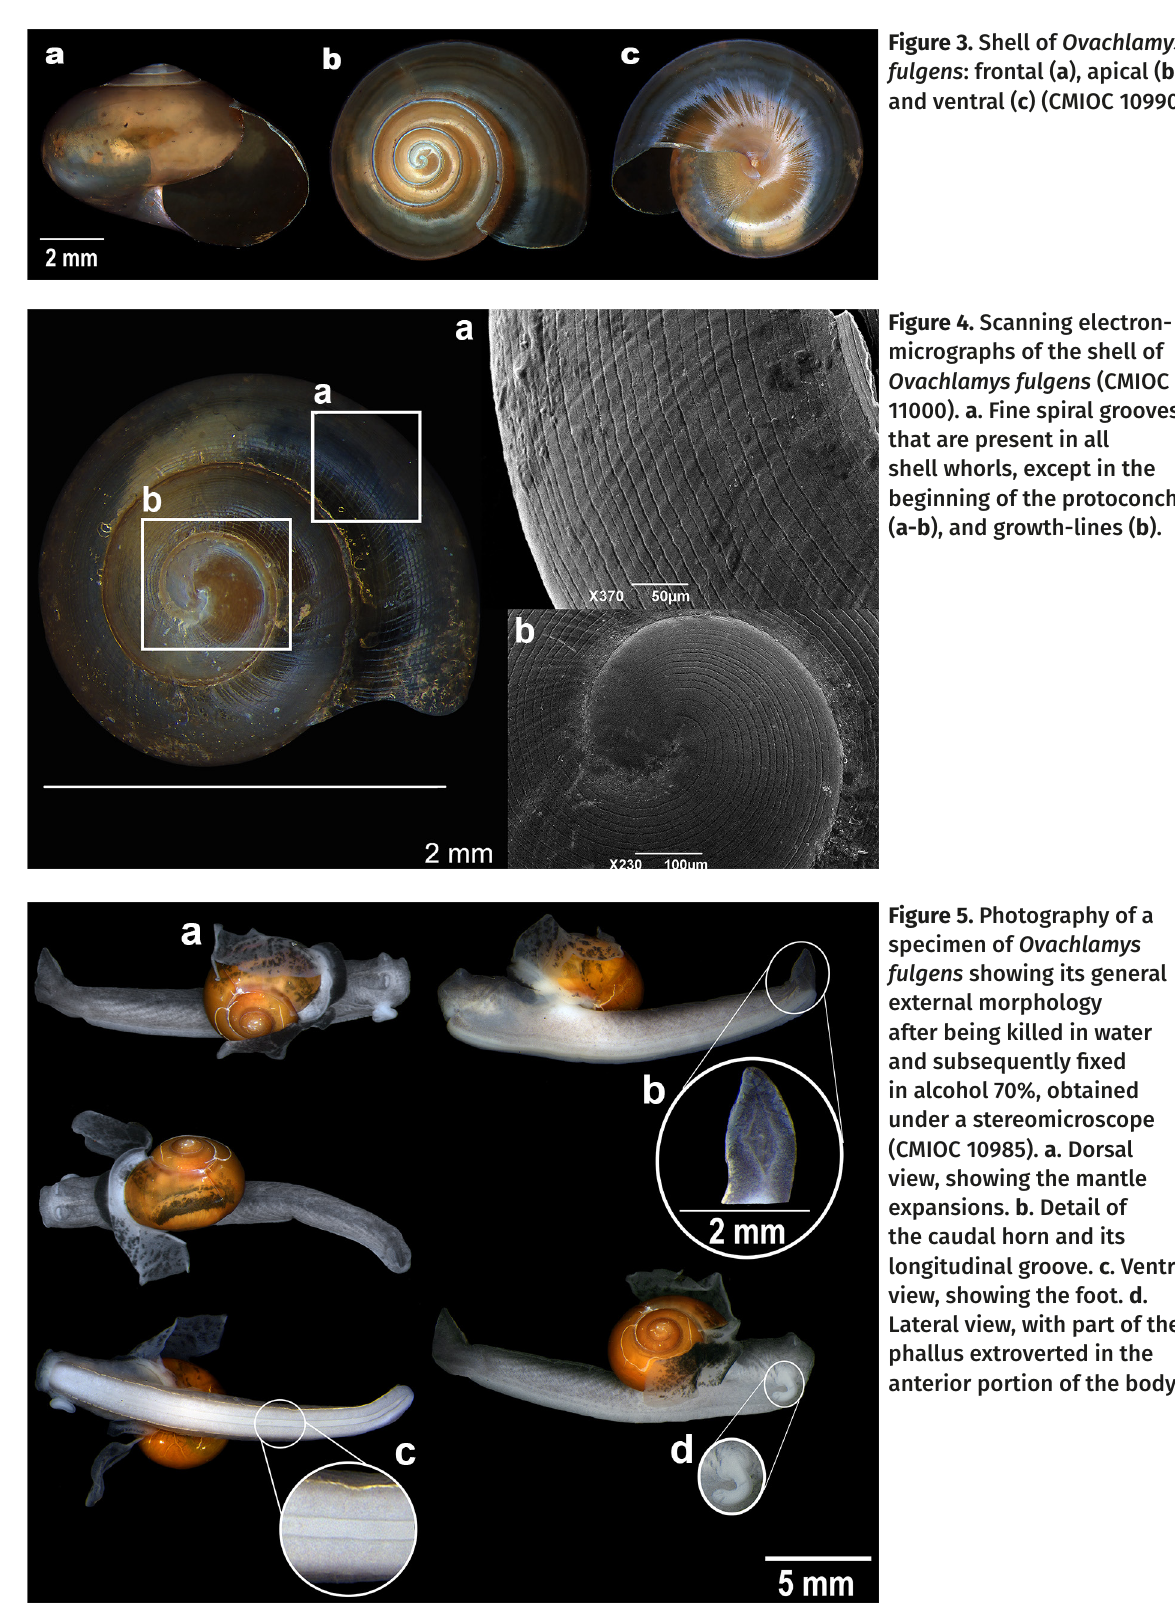
Figure 4. Scanning electron- micrographs of the shell of Ovachlamys fulgens (CMIOC 11000). a . Fine spiral grooves that are present in all shell whorls, except in the beginning of the protoconch ( a-b ), and growth-lines ( b ).